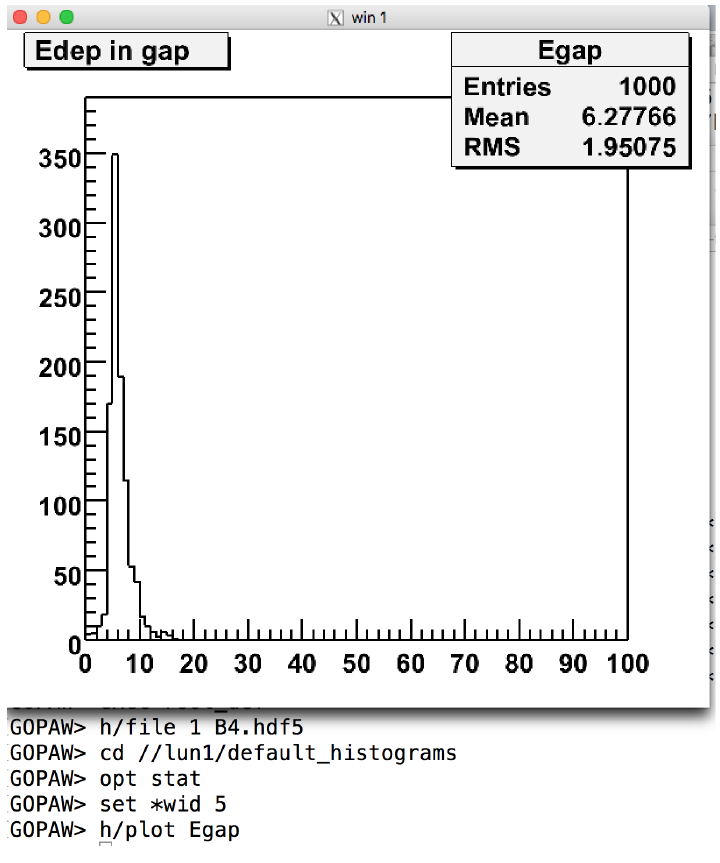
Figure 2. gopaw on the B4 HDF5